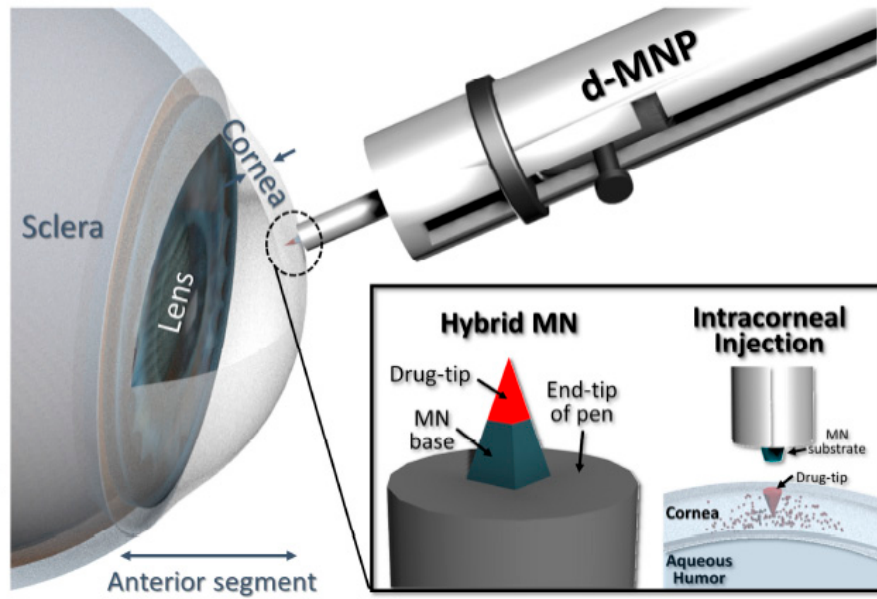
Figure 5. An overview of sustained drug release by microneedle. Adapted with permission from [45], Acta Biomater., 2018.